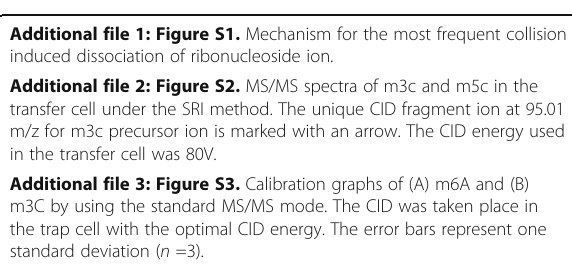
Additional file 1: Figure S1. Mechanism for the most frequent collision induced dissociation of ribonucleoside ion. Additional file 2: Figure S2. MS/MS spectra of m3c and m5c in the transfer cell under the SRI method. The unique CID fragment ion at 95.01 m/z for m3c precursor ion is marked with an arrow. The CID energy used in the transfer cell was 80V. Additional file 3: Figure S3. Calibration graphs of (A) m6A and (B) m3C by using the standard MS/MS mode. The CID was taken place in the trap cell with the optimal CID energy. The error bars represent one standard deviation ( n